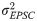
Variability in EPSC profile across independent events of single vesicle-release.(A) 150 sample temporal profiles of EPSC generation due to the stochastic activation of AMPARs located within the PSD in response to the numerically-obtained sample temporal profiles of local Cglut(t) under the independent events of vesicle-fusion are shown for the standard diffusion condition with zero σDglut. The ensemble mean across 600 such sample temporal profiles closely matches the analytically-obtained temporal profile of EPSC. (B-C) provide a similar observation for the cases with the non-zero values of σDglut. (D-F) shows the distribution of EPSC amplitudes across the ensemble for the individual values of σDglut. The EPSC amplitudes are found to always exhibit a Gaussian distribution (fitting correlations; r2 = 0.9797 for σDglut = 0, r2 = 0.9585 for σDglut = 80, and r2 = 0.9663 for σDglut = 140). The corresponding values of CVEPSC are also mentioned. (G) The error-bar plot of variation in the mean EPSC amplitude with change in σDglut. The solid circles represent the mean EPSC amplitude whereas the vertical lines represent one standard deviation of the amplitude distribution around its mean. It is seen that the mean EPSC amplitude increases with the increase in σDglut. (H) and (I) show the linear fittings to the change in the variance, σEPSC2, and CVEPSC of the EPSC amplitude distribution with change in σDglut, respectively. σEPSC2 is seen to very slowly increase with the increase in the σDglut whereas the CVEPSC gradually decreases (almost 27%) depicting an increase in the reliability of synaptic transmission.